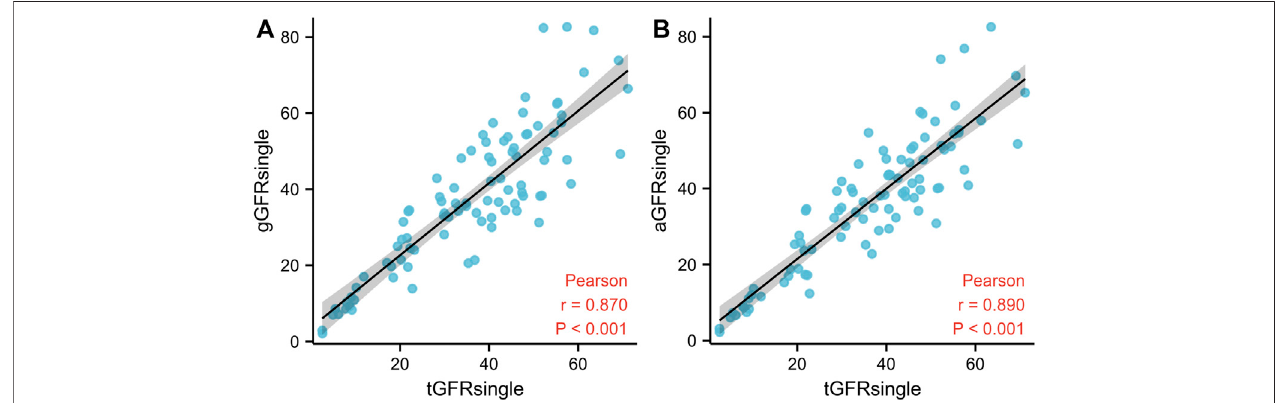
FIGURE 3 | The relationship between gGFR single and tGFR single (A) and between aGFR single and tGFR single (B) in patients with hydronephrosis. The solid line represents linear correlation. GFR, glomerular fi ltration rate; gGFR single , single GFR measured using the Gates method; aGFR single , single GFR measured by the renal region of interest area correction by CT method; tGFR single , the single GFR, total GFR measured by the two-sample method multiplied by the differential renal